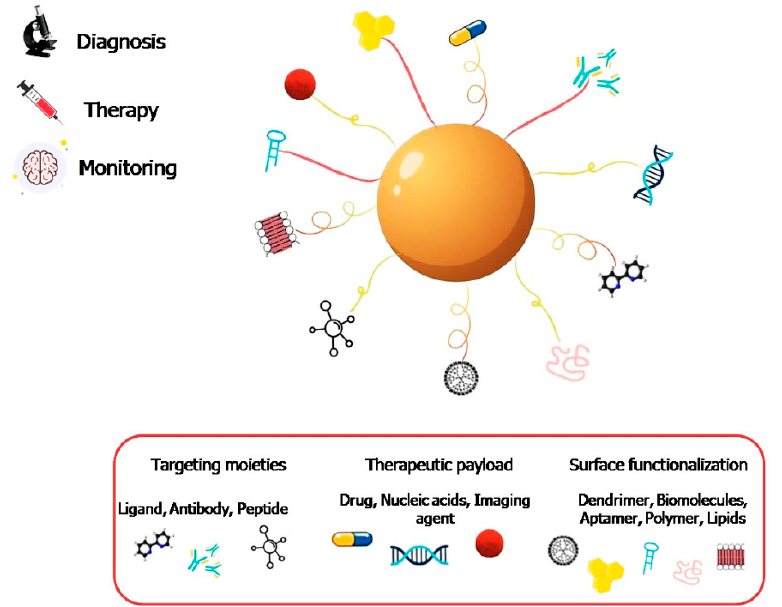
Figure 4. Design and application fields of multimodal theranostic nanoparticles. Targeting moieties, therapeutic payload, and surface decoration are exemplified in the picture, providing a series of useful tools to improve clinical outcomes.